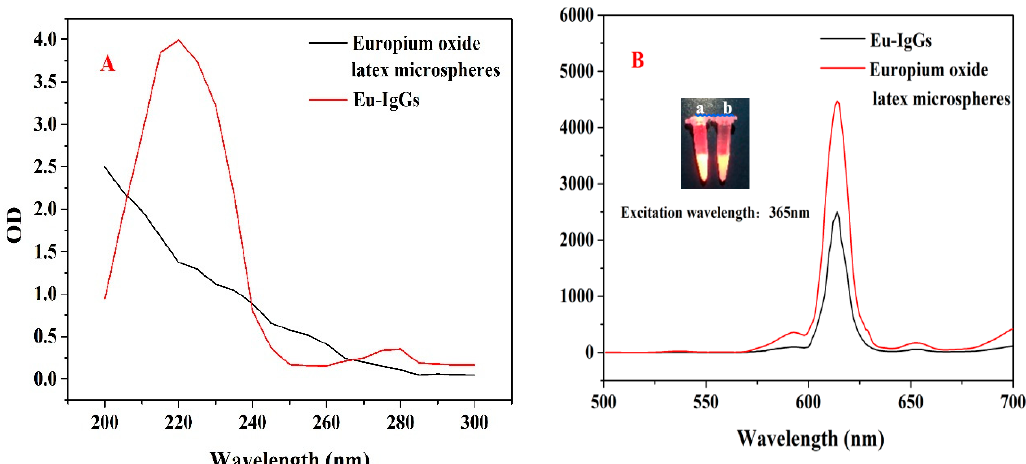
Figure 3. ( A ) Uv-vis absorption spectra of europium oxide latex microspheres before and after sheep anti-mouse IgG conjugation; ( B ) Fluorescence spectra of europium oxide latex microspheres before